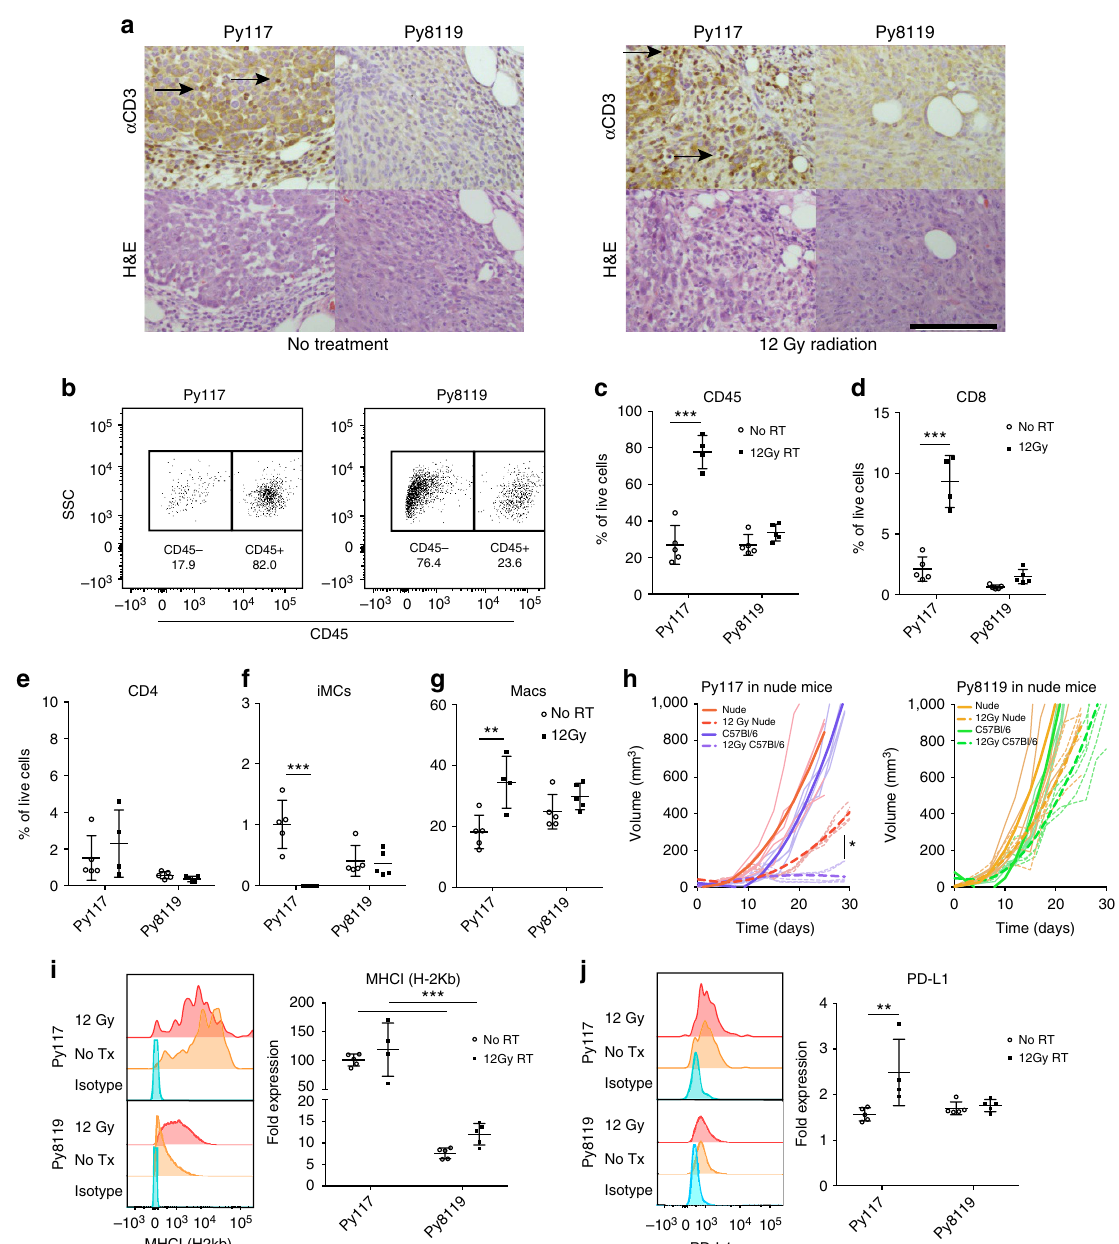
Figure 2 | Radiosensitivity is associated with a differential antitumour immune response. ( a ) CD3 T-cell (arrows) immunohistochemistry 10 days after 12Gy of radiation reveals increased infiltrates with and without radiation in Py117 compared with Py8119 tumours (scale bar, 100 m m). ( b ) Dissociated tumours analysed by flow cytometry had a greater proportion of CD45 þ leukocytes after radiation in the Py117 tumours. ( c ) Quantification revealed an influx of leukocytes after radiation in Py117 tumours but not in Py8119 tumours (4–5 mice per group). The Py117 immune infiltrate consists of CD8 þ T-cell influx ( d ), no change in CD4 þ T-cells ( e ), a decrease in immature myeloid cells (iMCs: CD45 þ CD11b þ Gr1 hi ) ( f ), and an increase in macrophages (CD45 þ CD11b þ F4/80 þ ) ( g ), with little differences in Py8119 tumours. ( h ) Implantation of tumours into nude mice revealed a decreased radiation response in Py117 tumours compared with syngeneic C57Bl/6 host and Py8119 curves were no different regardless of the host (Bold curves ¼ repeated measures curve, thin curves ¼ each mouse, five mice per condition). ( i ) MHCI (H-2Kb) is expressed on dissociated Py117 CD45 (cid:2) cells at 10 (cid:3) greater levels than in Py8119 tumours. ( j ) PD-L1 expression increased on dissociated Py117 CD45 (cid:2) cells after radiation but not Py8119 cells. ** P o 0.007, *** P o 0.0003 by two-way analysis of variance. * P ¼ 0.028 by repeated measures. All error bars, mean and s.d. diminished radiation response, depletion of NK cells had no effect, P ¼ 0.002 and 0.0004, respectively (Fig. 3b). The antitumour and depletion of CD4 þ cells resulted in greater activity response of combination treatment lead to increased survival of (Supplementary Fig. 3). This confirms the importance of CD8 þ mice with Py117 tumours but not mice with Py8119 tumours effector T-cells. Despite low number of CD4 þ T-cells, if they are (Fig. 3c). Py117 mice were then treated with depleting antibodies Tregs, they may blunt the antitumour response, explaining the added for CD8 þ , CD4 þ and NK cells to determine the relative impor- tance of each cell type. We found that CD8 þ depletion resulted in a benefit of a single CTLA-4 dose 24 . NATURE COMMUNICATIONS|7:13898|DOI: